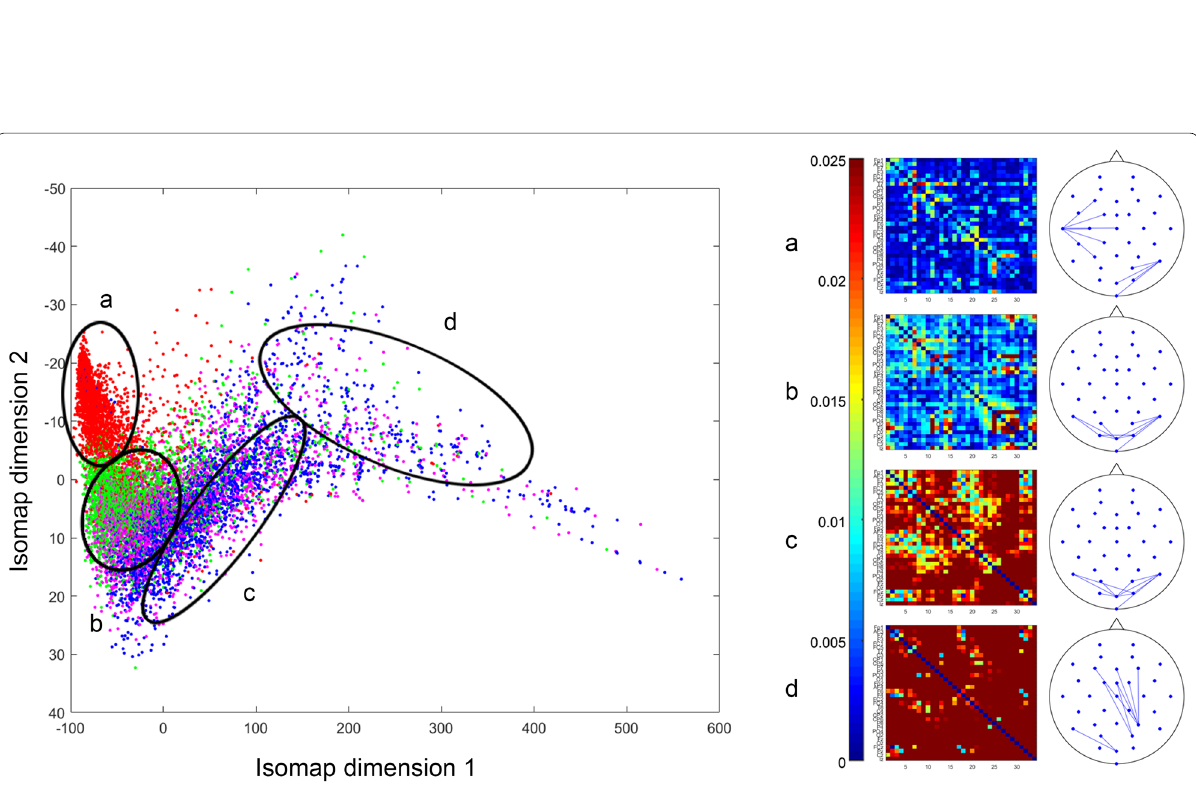
Fig. 5 An ε -isomap-based illustration of mean 34 × 34 theta EEG connectomes of four distinct segments of the manifold: the head ( a ), the mid and posterior body ( b , c ) and the tail ( d ) (left). For each mean connectome, its ten strongest edges were visualized on the layout of the electrodes